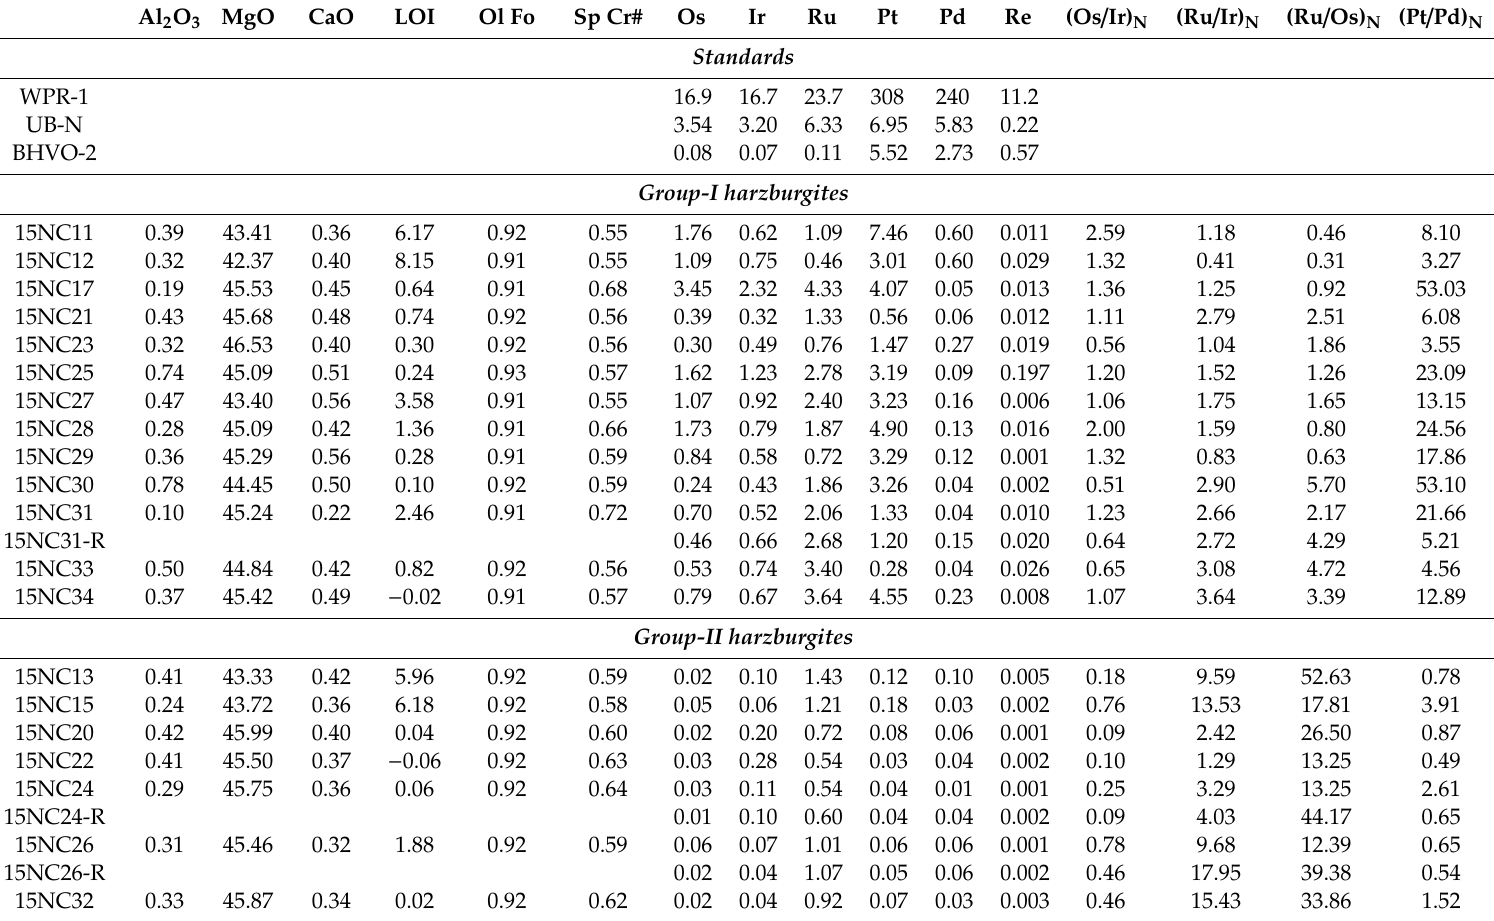
Table 1. Highly siderophile elements (HSE) data (in ppb) of the Me Maoya